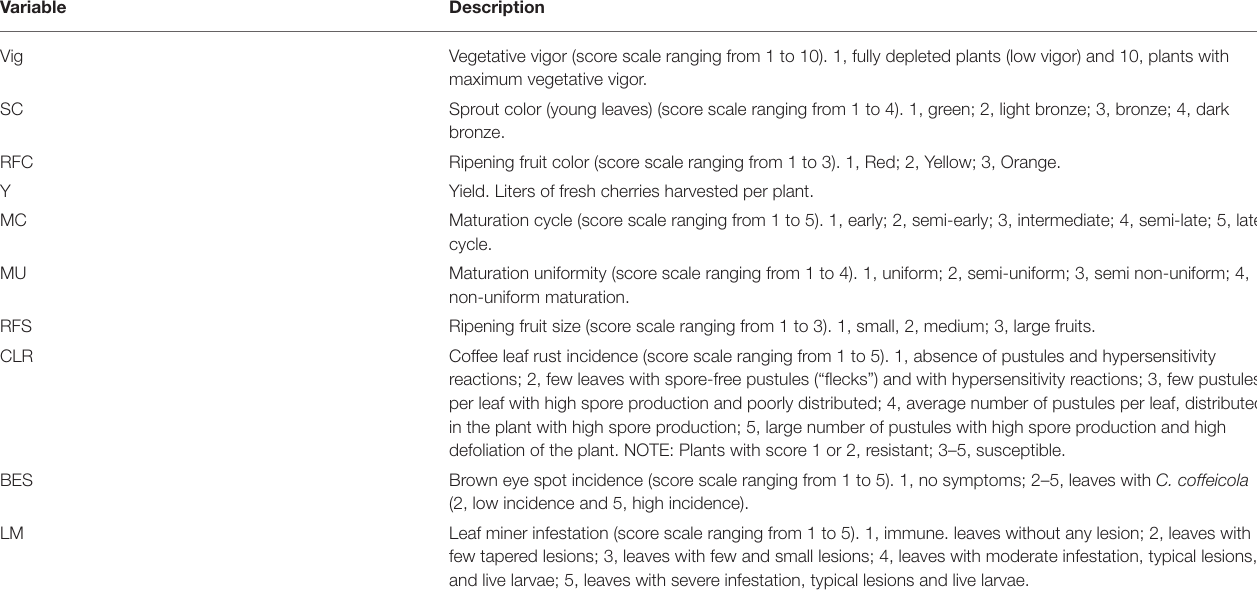
TABLE 4 | Phenotypic traits evaluated in eight progenitors of arabica coffee and 12 F 1 hybrids obtained by crossing in a circulating diallel scheme. Variable